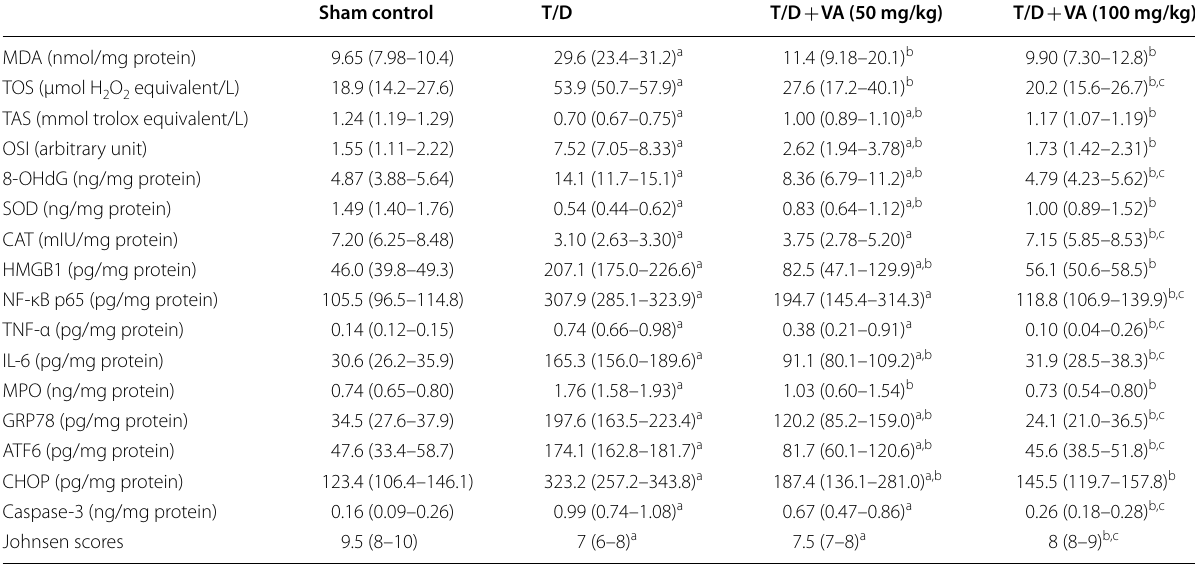
T/D, torsion/detorsion; VA, vanillic acid; MDA, malondialdehyde; TOS, total oxidant status; TAS, total antioxidant status; OSI, oxidative stress index; 8-OHdG, 8-hydroxy- 2 ′ -deoxyguanosine; SOD, superoxide dismutase; CAT, catalase; HMGB1, high-mobility group box 1; NF-κB, nuclear factor kappa B; TNF-α, tumor necrosis